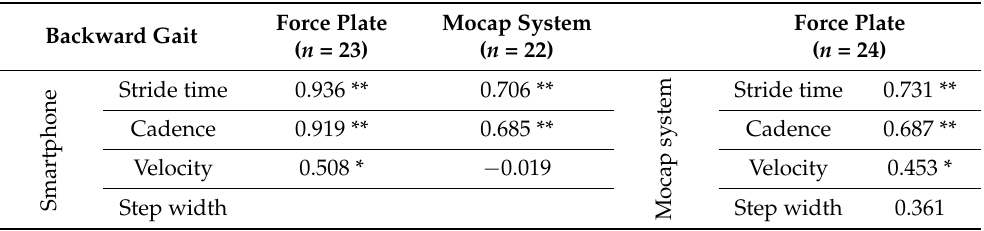
Table 6. Between-system correlations for backward gait between the force plate, mocap system and smartphone at T1 (first measurement time). Correlation after